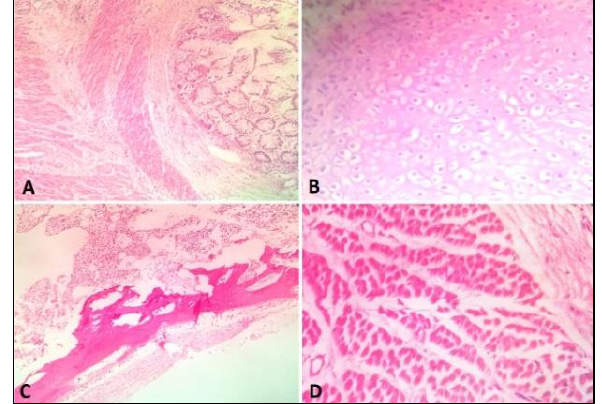
Figure 3: Histopathology showing mature teratoma. A-D Gut mucosa, cartilage, bone and skeletal muscle, re-